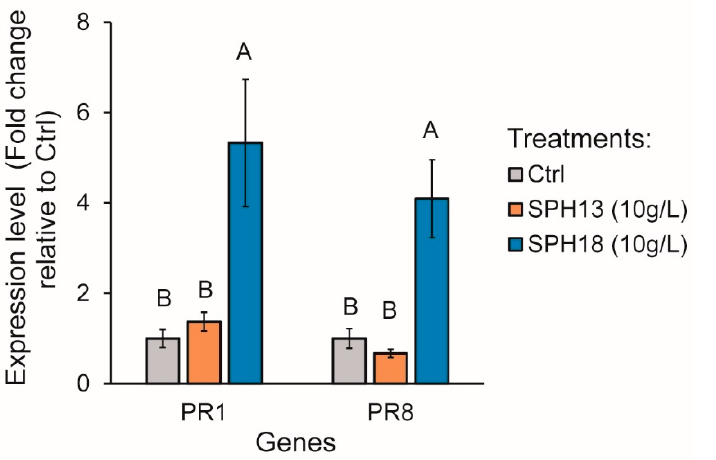
Figure 3. Impact of the drench application of SPH13 and SPH18 on the expression of PR1 and PR8, two defence-related genes. The total RNAs were extracted from leaf samples taken from Micro Tom plants, 2 days after the treatments with SPH13 and SPH18 at 10 g L − 1 or water (Ctrl). RT-qPCR analysis of pathogenesis-related 1 (PR1) and PR8 ( n = 3 to 4; one-way ANOVAs and post hoc LSD tests were performed for each gene separately, p < 0.05, means with the same letter are not significantly different). Tomato seeds were sown on 11 July 2021.